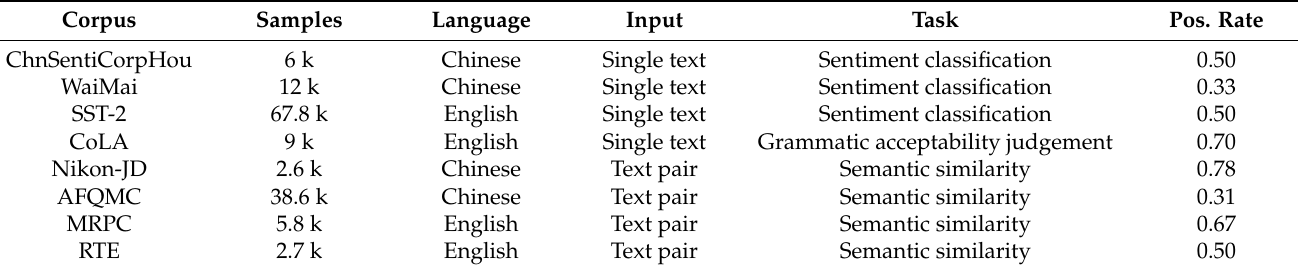
Table 3. Statistics of the eight datasets used in this article. Pos. Rate indicates the ratio of positive instances in the corresponding